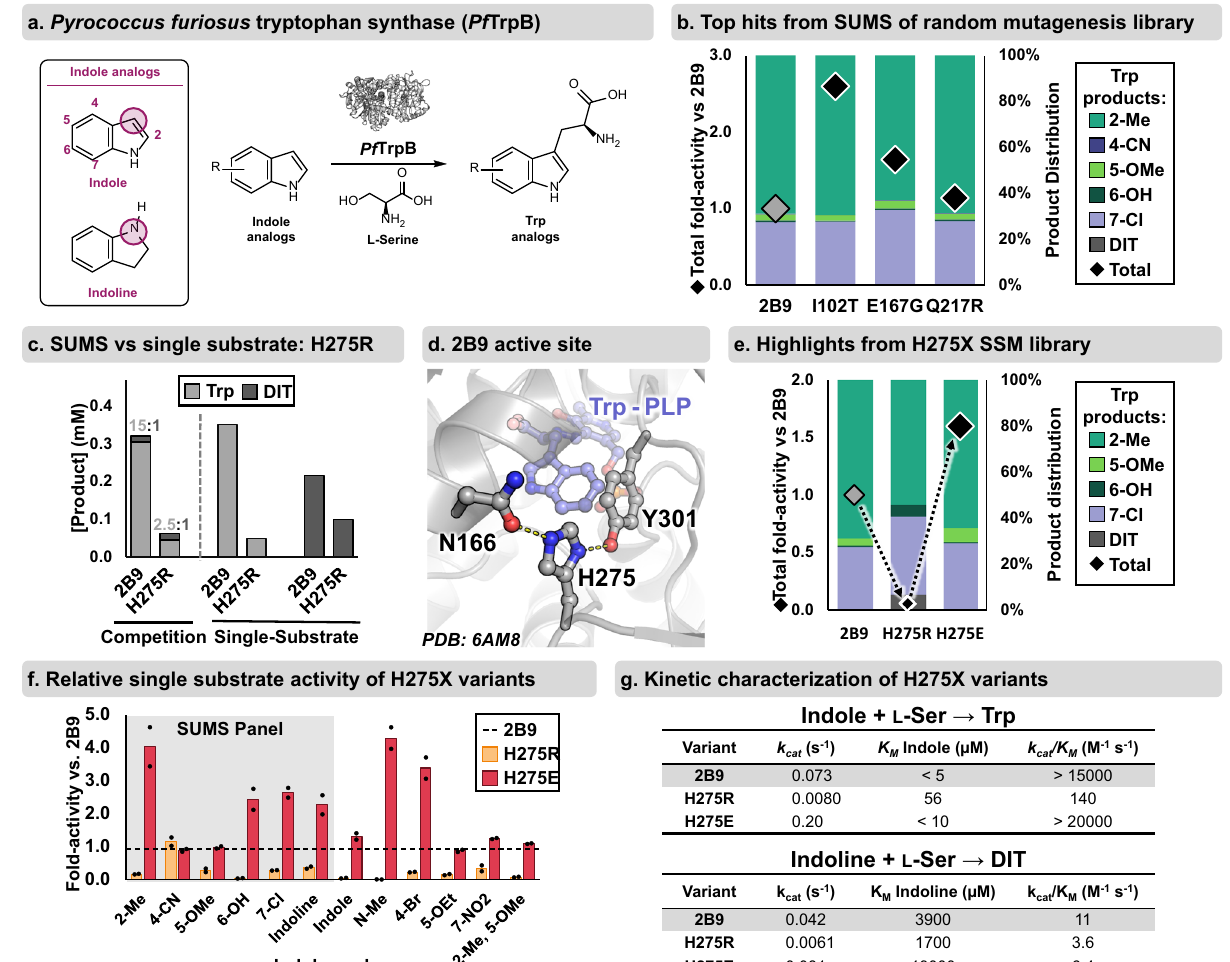
Fig. 4 | SUMS-based engineering of the β -subunit of Pyrococcus furiosus tryp- tophan synthase ( Pf TrpB). a General reaction scheme for Pf TrpB. Indole analogs were used to screen Pf TrpB libraries. The nucleophilic atom is shown with a circle. R =halo, alkyl, nitro, ether, etc. See ref. 47 for a detailed scope of engineered TrpB enzymes. b SUMS results for generally activated variants detected during globally random mutagenesis library screening. Complete library results and experimental conditions are shown in Supplementary Figs. 23 – 25. c Comparison of Trp and DIT production under competition and single substrate reaction conditions, using puri fi ed 2B9 and H275R enzymes. Indoline was present at 10-fold excess (15mM indoline, 1.5mM indole) for both competition and single substrate reactions.